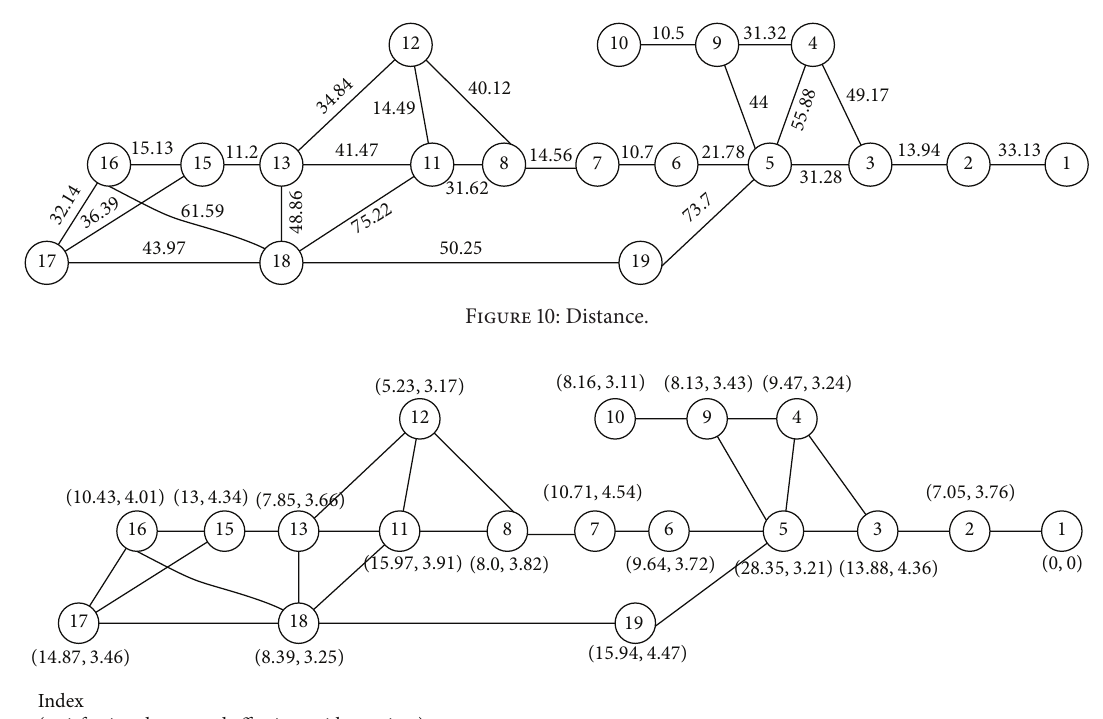
Figure 10: Distance.